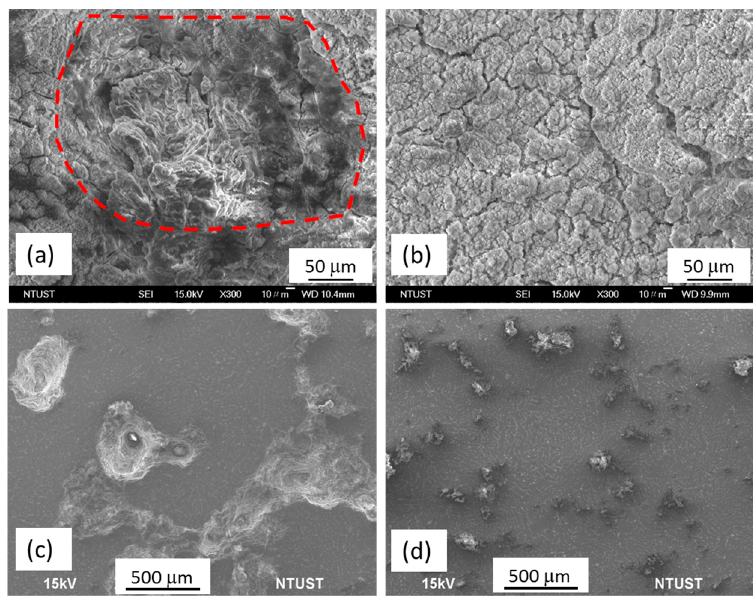
Figure 10. SEM micrographs of as-cast alloys after immersion in SBF: surface morphology of ( a ) MgZnY-C alloy and ( b ) HA-C; corresponding morphology of ( c ) MgZnY-C alloy and ( d ) HA-C alloys after removing corrosion products.